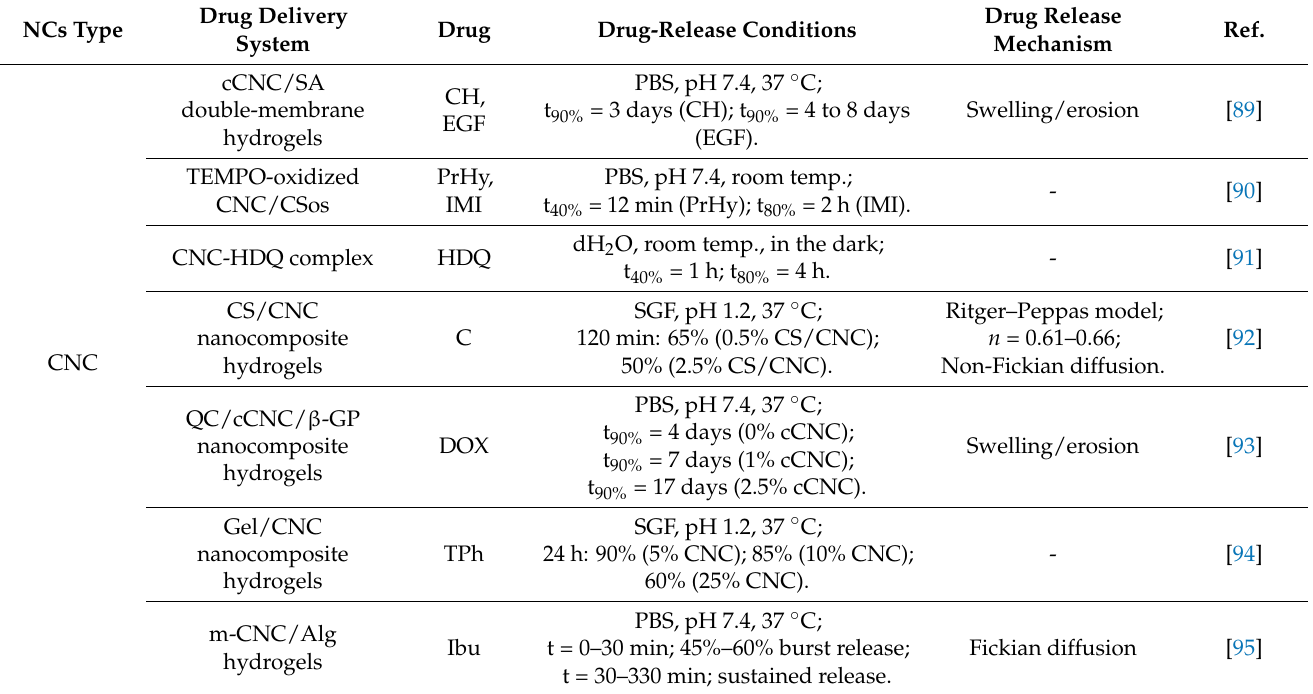
Table 1. Nanocellulose hydrogels/nanocomposites in drug-delivery